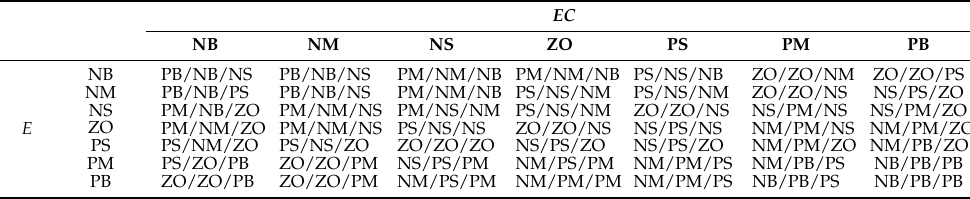
Table 2. Fuzzy control rules table of ∆ K p , ∆ K i , ∆ K d